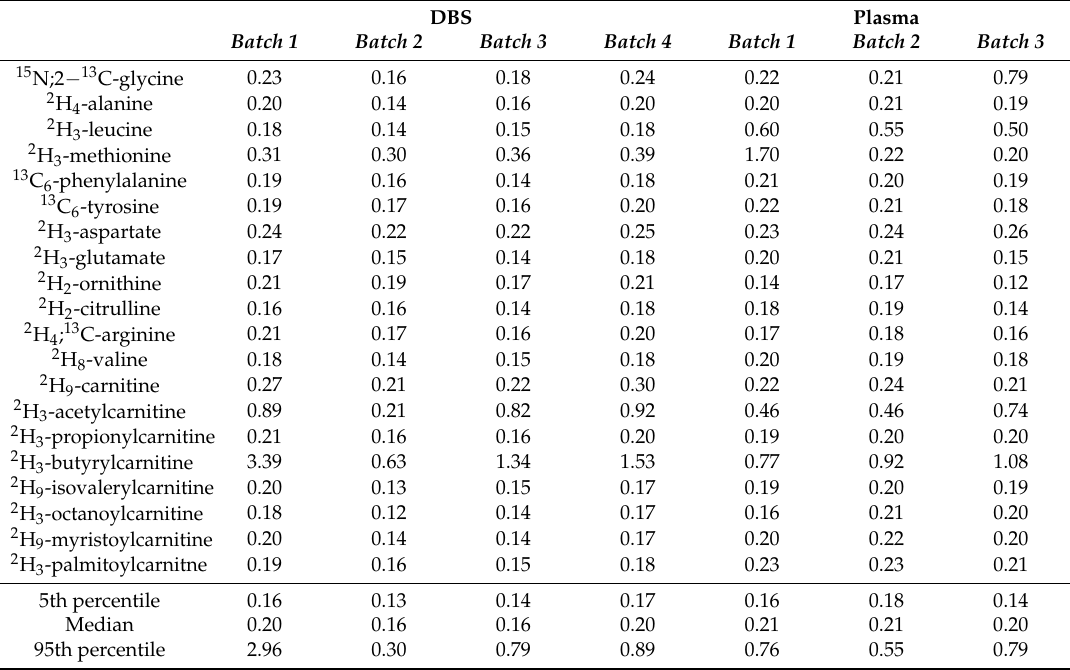
Table 2. Within-batch variation: relative standard deviation of stable isotope-labeled compounds.